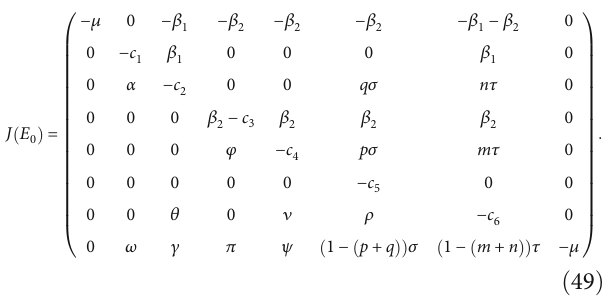
Figure 13: Impacts of contact rates β ones ( I TC